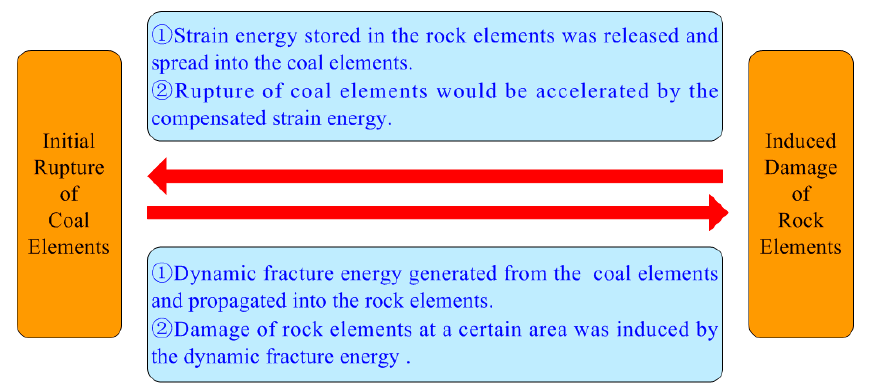
Figure 12. Interactions between the coal elements and the rock elements in the sandwiched coal-rock system.